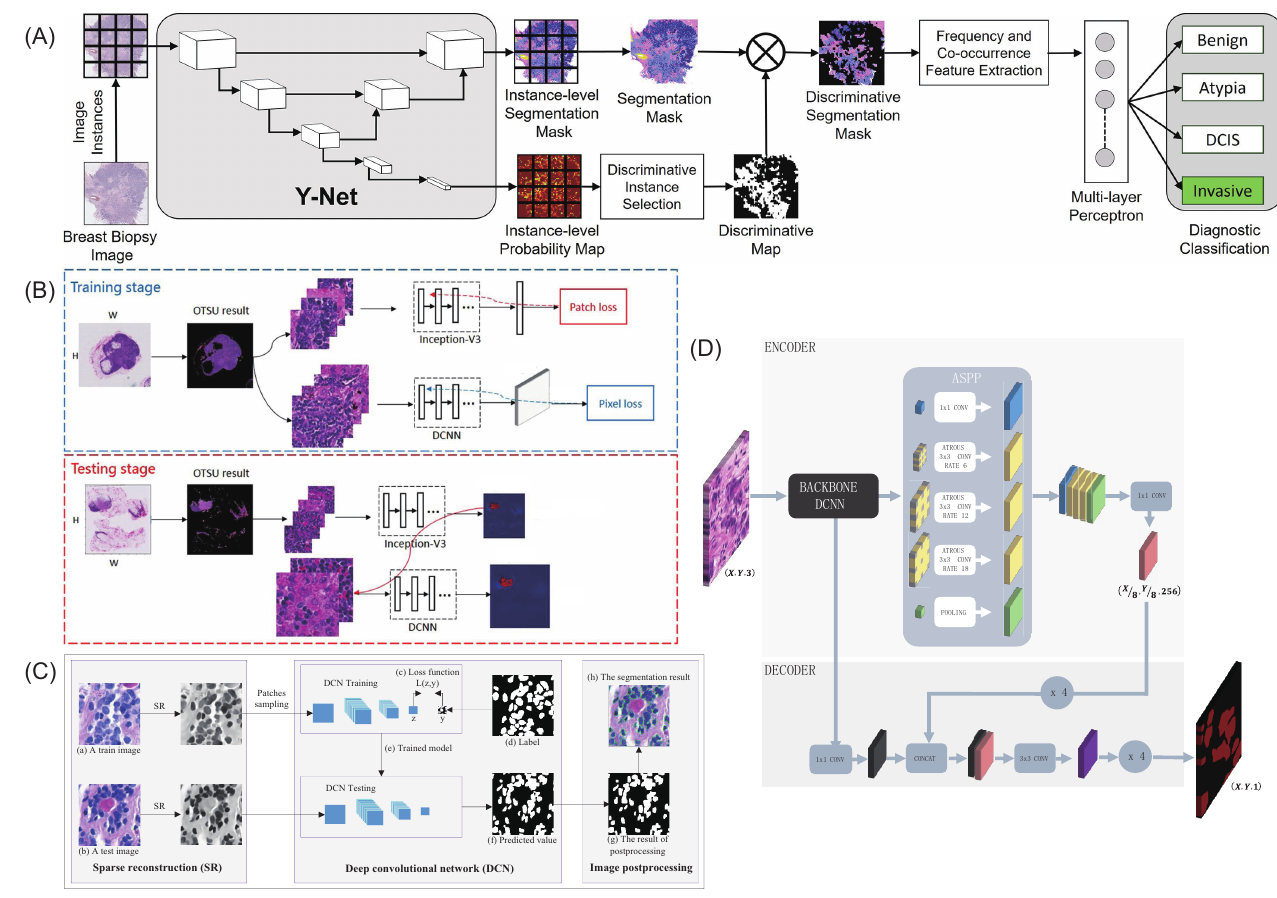
Figure 4. Some typical models of breast pathological image segmentation. ( A ) Overview of methods for detecting breast cancer reported by Mehta et al. ( B ) The fast and refined cancer region segmen- tation framework v3_DCNN reported by Guo et al. ( C ) The method reported by Pan et al. ( D ) The deep neural network-based pipeline segmentation method reported by Maria Priego-Torres et